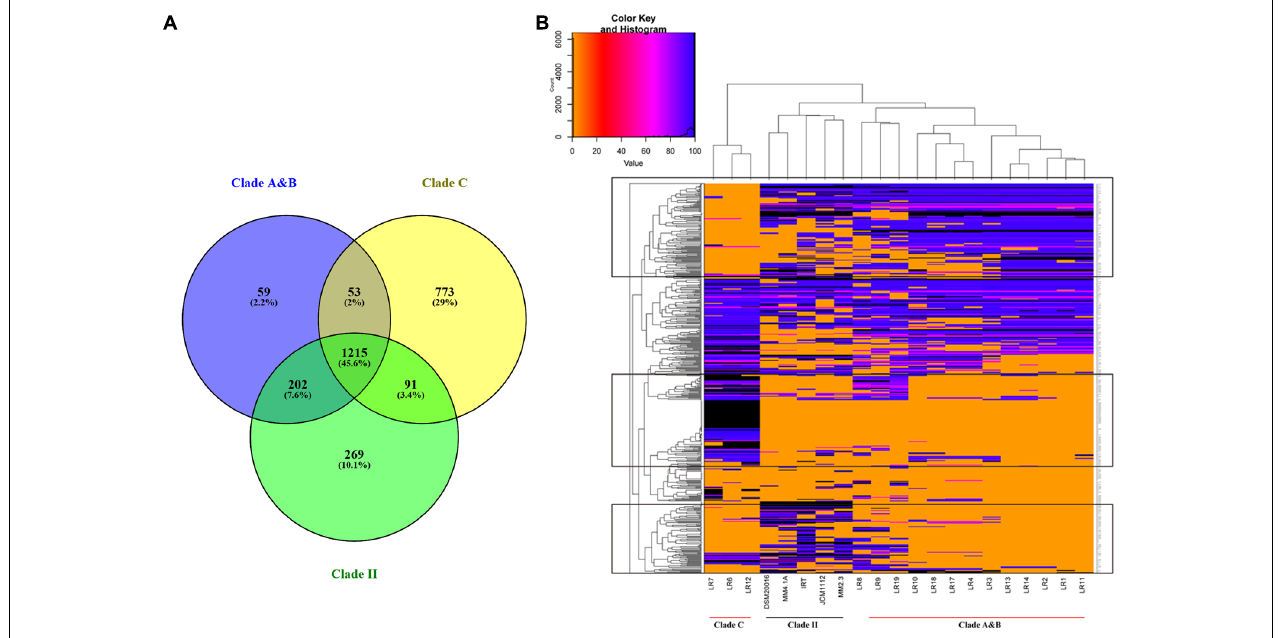
FIGURE 4 | Shared and unique gene families of Lactobacillus reuteri strains from different clades of herbivore-derived L. reuteri strains (A) . Venn plot showing shared and unique genes distribution (B) . A heatmap representation of BLASTN comparison of specific genes against sequenced L. reuteri genomes.